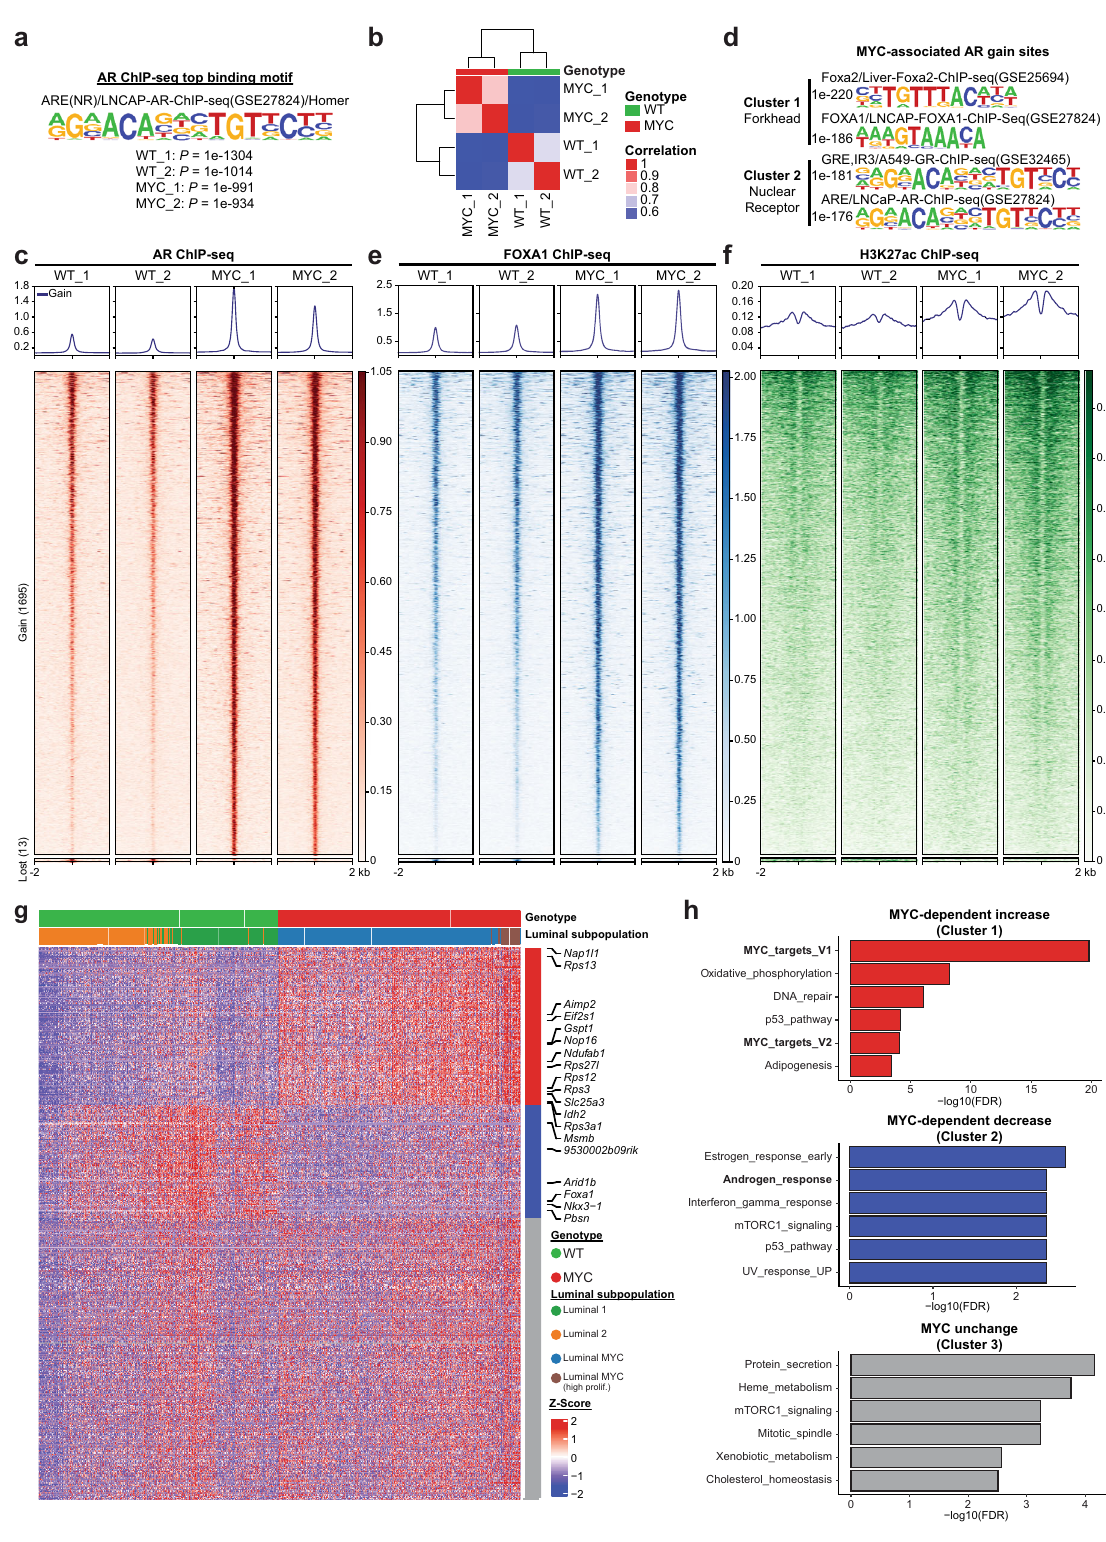
AR ChIP-seq top binding motif